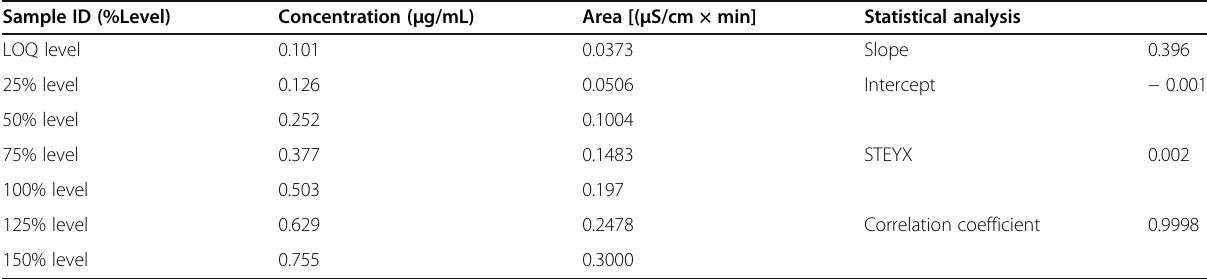
Table 2 Statistical data of